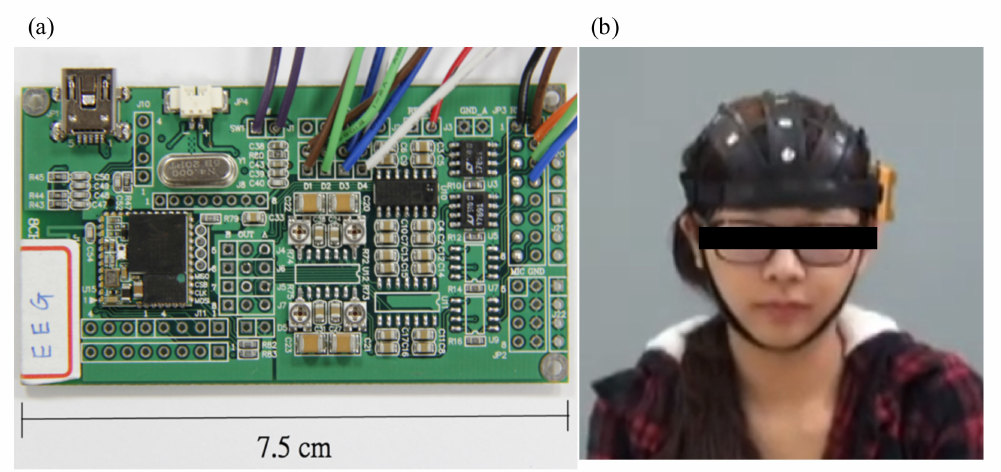
Figure 2. Photographs of ( a ) our EEG acquisition module and ( b ) the EEG cap embedded with the